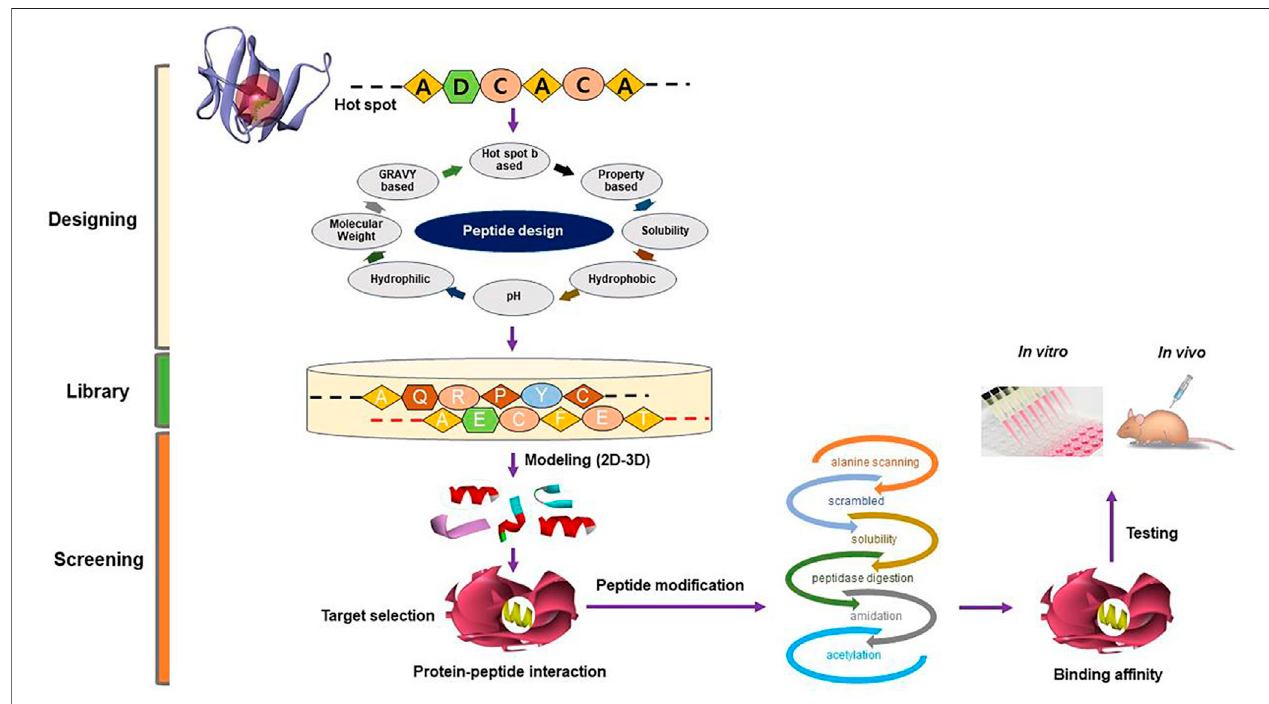
FIGURE 3 | A fl owchart depicting the work fl ow for in silico peptide